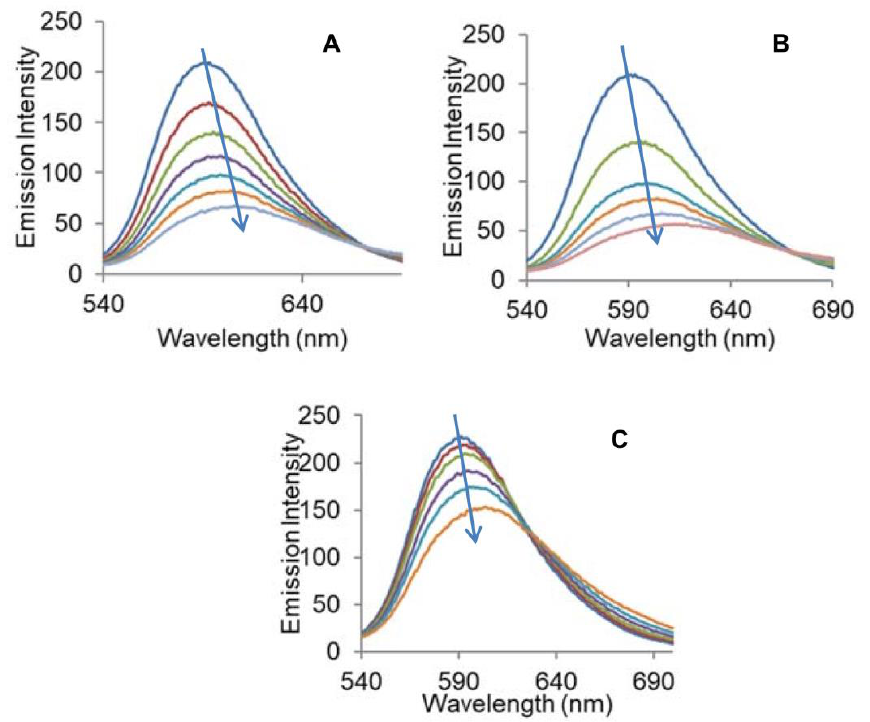
Figure 4. Quenching spectra of EtBr-DNA adduct by the complexes ( A) 1 , ( B ) 2 , and ( C ) 3 , with CT-DNA in 5 mM Tris-HCl/50 mM NaCl buffer of pH 7.5 at room temperature.